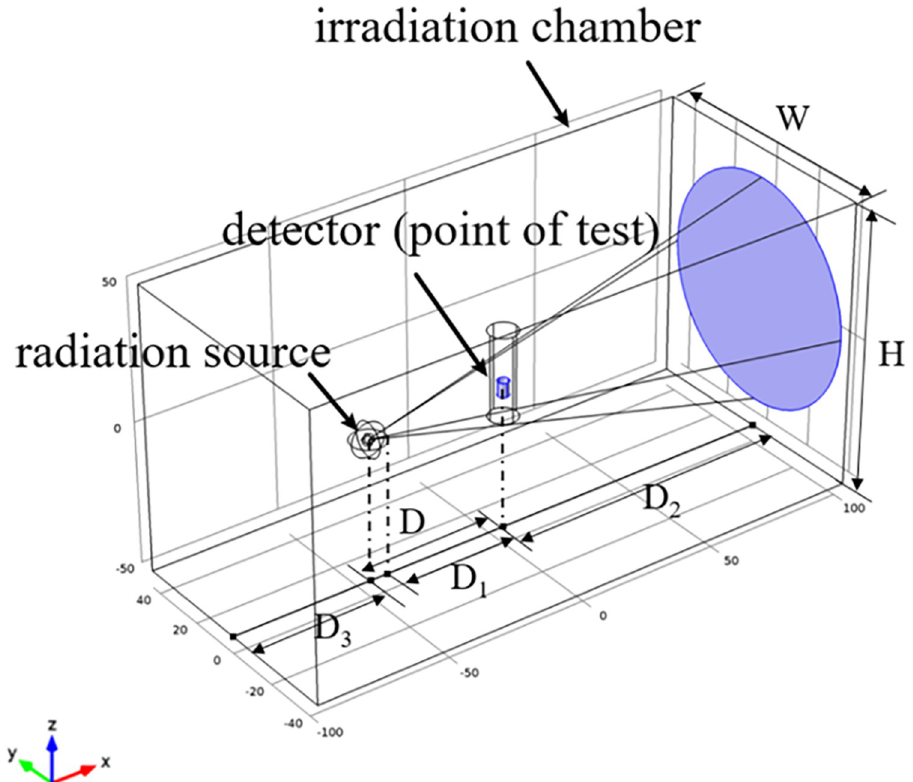
Fig 1. Physical model of collimated reference radiation